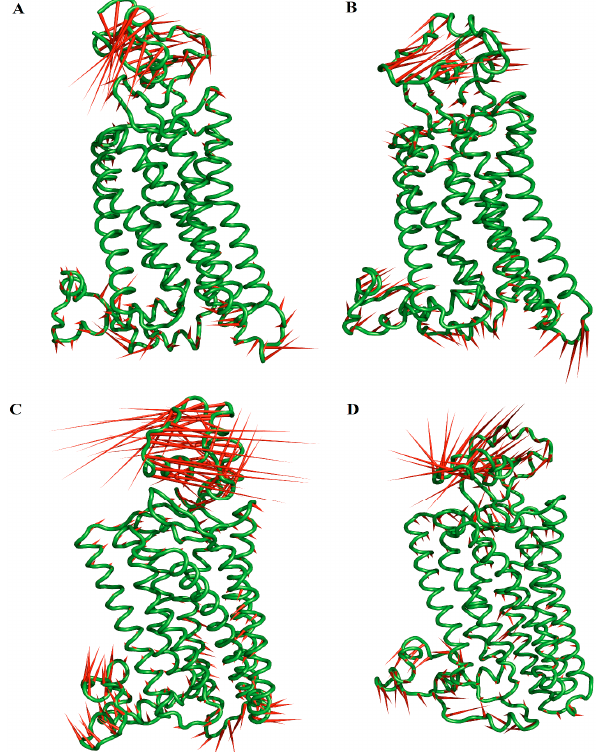
Figure 4. Graphic representation of the two extreme projections of the free and bound hMOR systems. Graphical depiction of the two extreme projections along PC1 vs. PC2 for the free hMOR ( A ), hMOR–naltrexone ( B ), hMOR–NTXOL ( C ), and hMOR–HMNTXOL ( D ) systems. The direction and magnitude of motions are depicted as porcupine depictions.